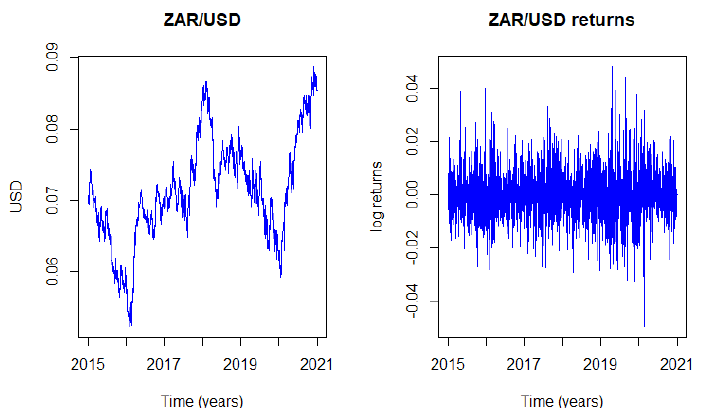
Figure 2. Plot of ZAR/USD prices (left) and one-day log returns (right)